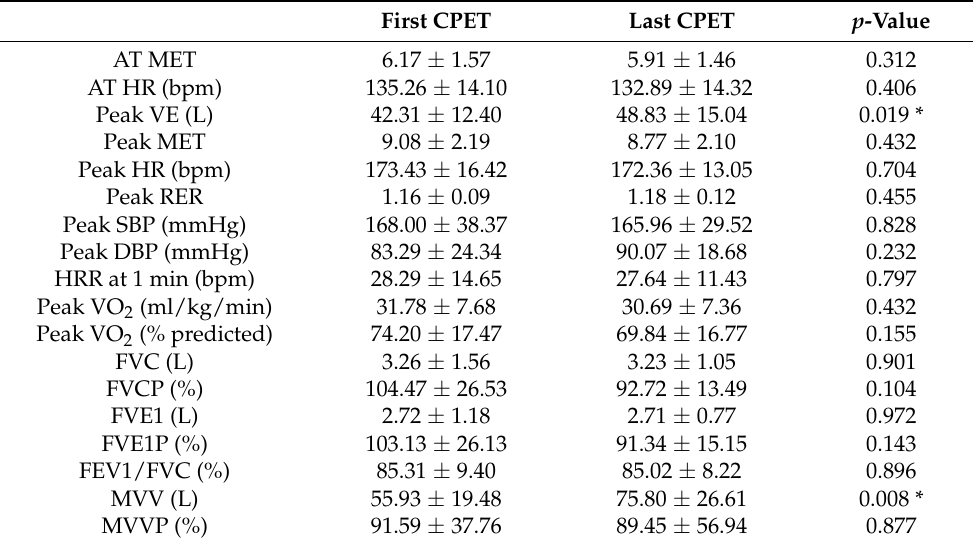
Table 4. Comparison between the initial and final exercising testing and pulmonary function testing data in patients with pulmonary valve stenosis.